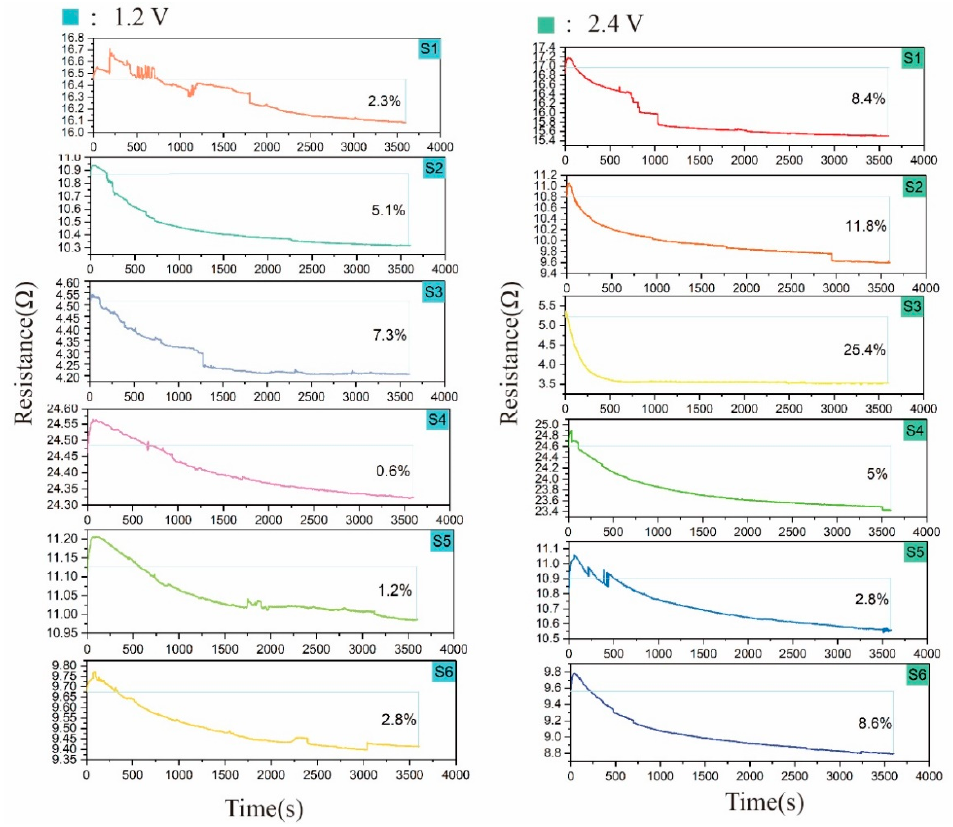
Figure 5. Resistance values of S1–S6 at 1.2 and 2.4 V for 1 h.